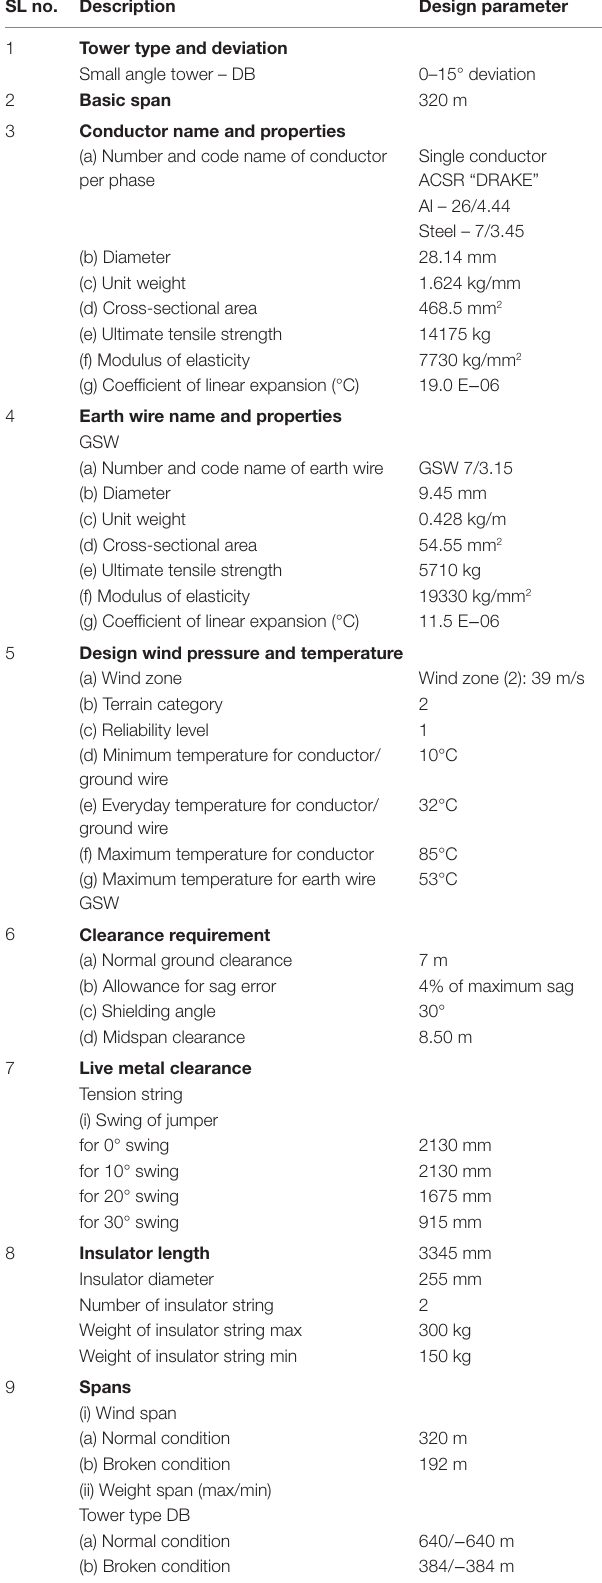
TaBle 1 | Design data for a typical 220-kV transmission